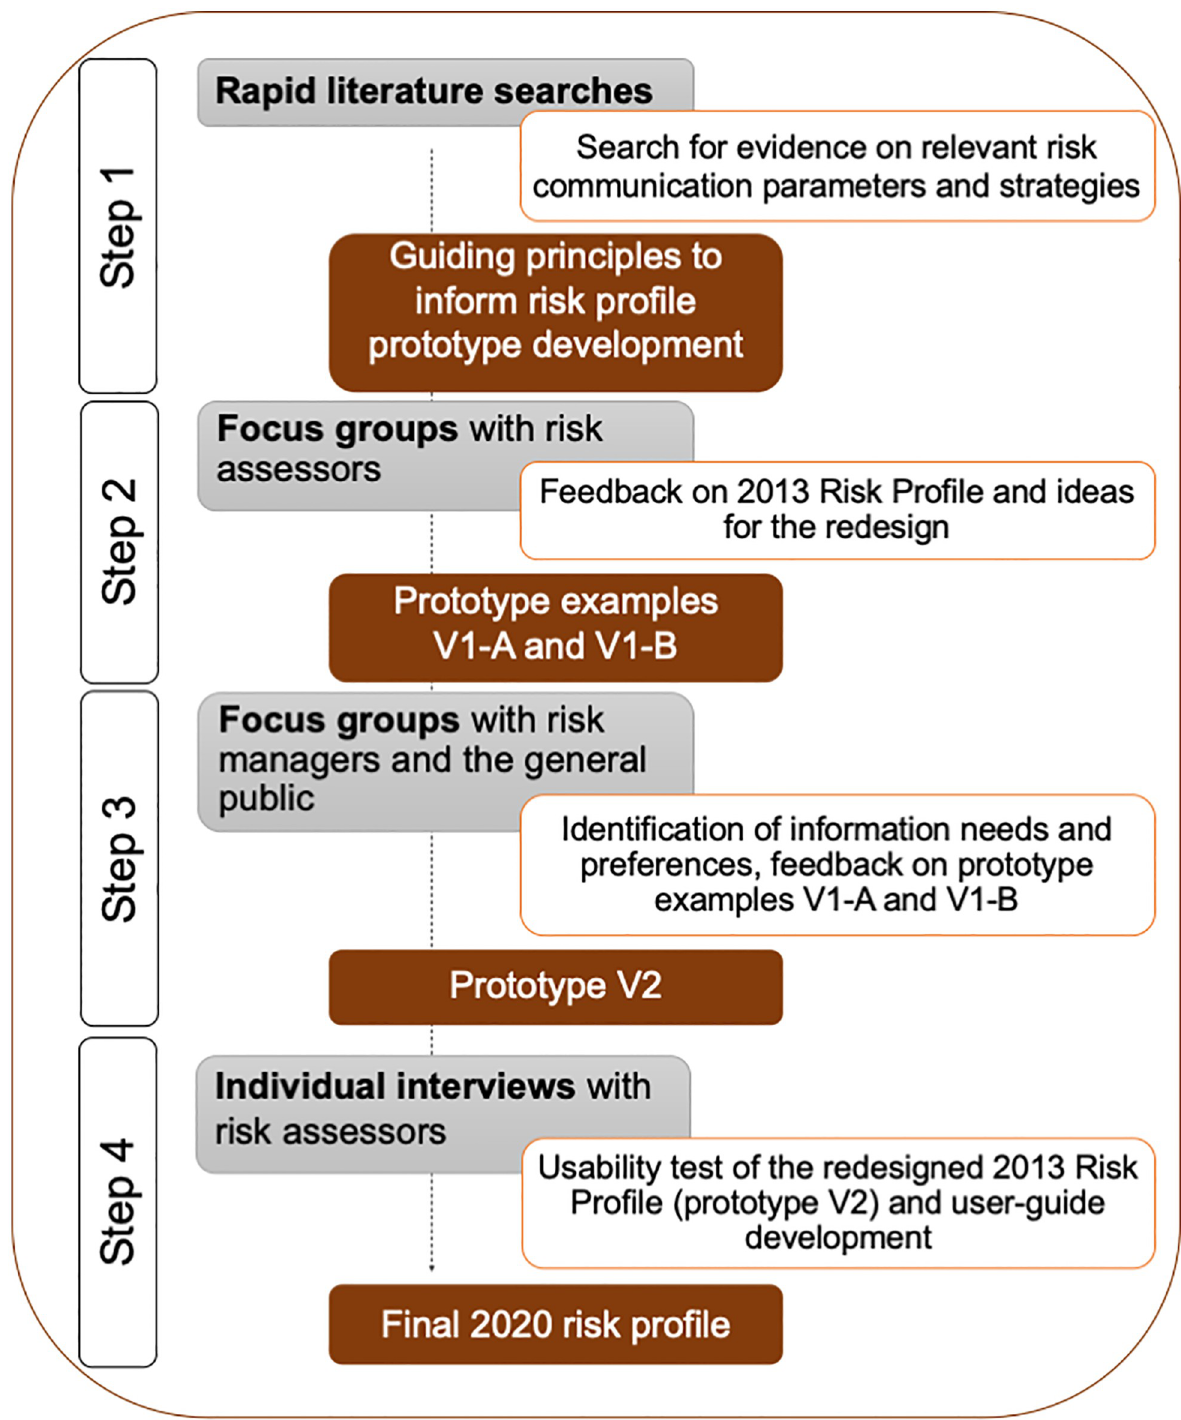
Fig 2. Flowchart showing the successive steps taken to identify content and strategies to redesign the 2013 BfR Risk Profile.